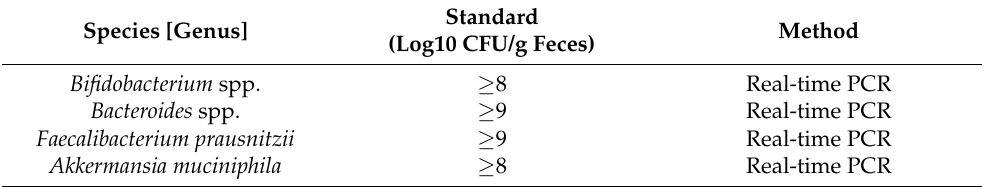
Table 3. Reference values for selected